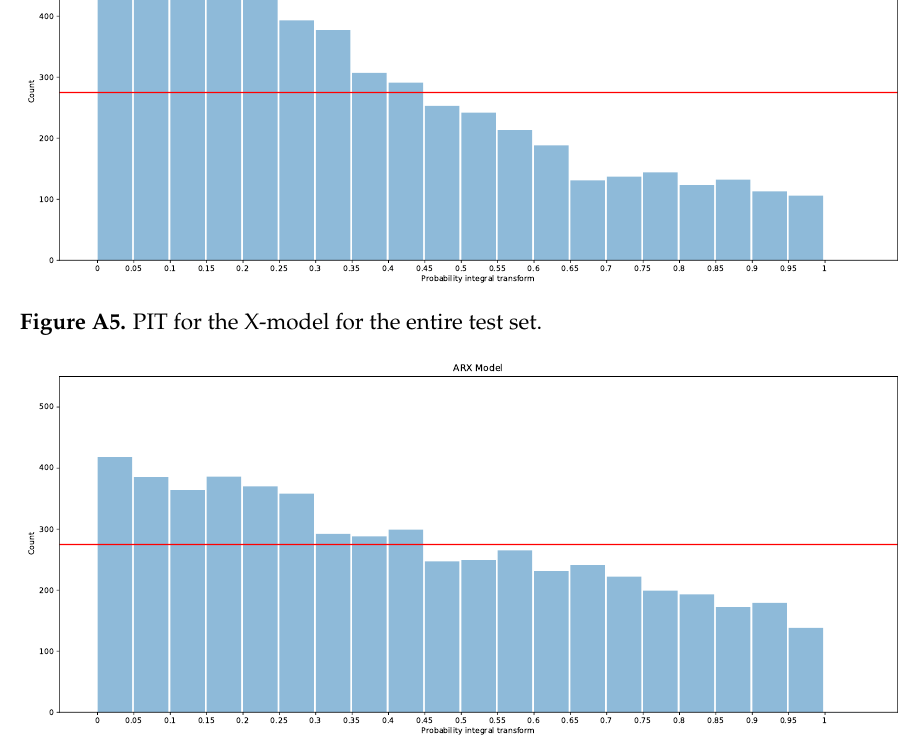
Figure A6. PIT for the ARX model for the entire test